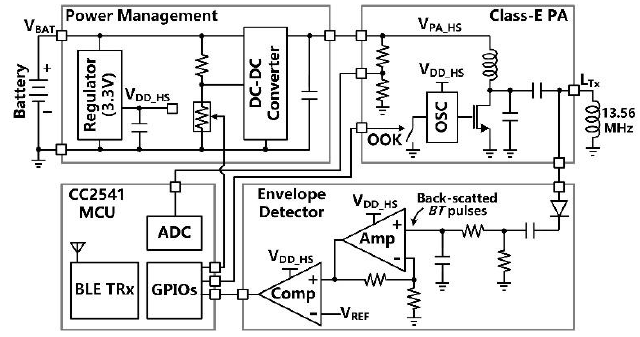
Figure 5. Block diagram of the headstage.